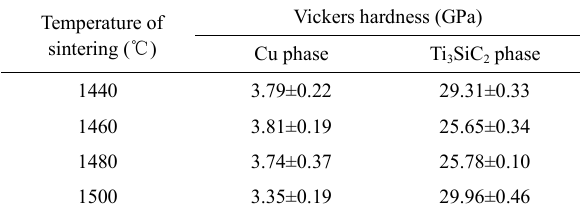
Table 4 Vickers hardness of different phases